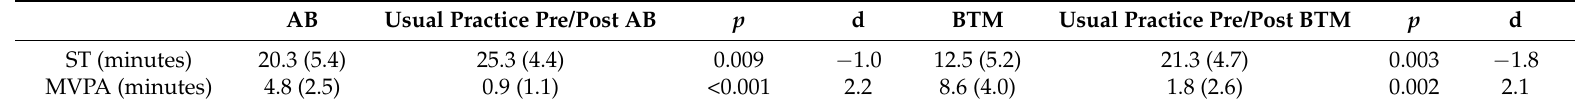
Table 2. ST and MVPA accrued during the 30-min windows including an AB, BTM video, and usual classroom practice (mean and standard deviation). AB Usual Practice Pre/Post AB p d BTM Usual Practice Pre/Post BTM p d ST (minutes)